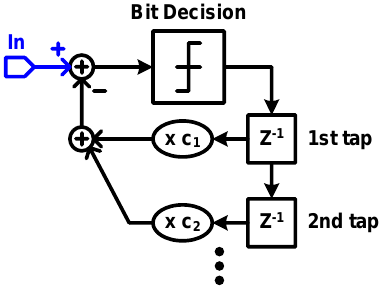
Figure 39. Simplified block diagram of DFE.